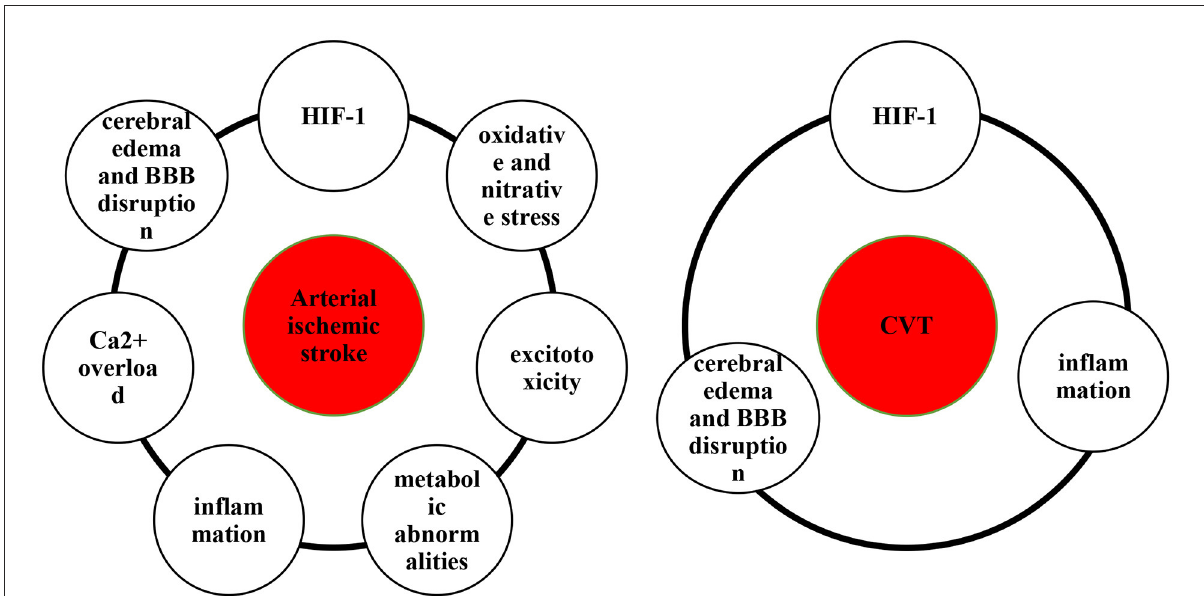
FIGURE1 The molecular pathological hallmarks of arterial stroke and cerebral venous